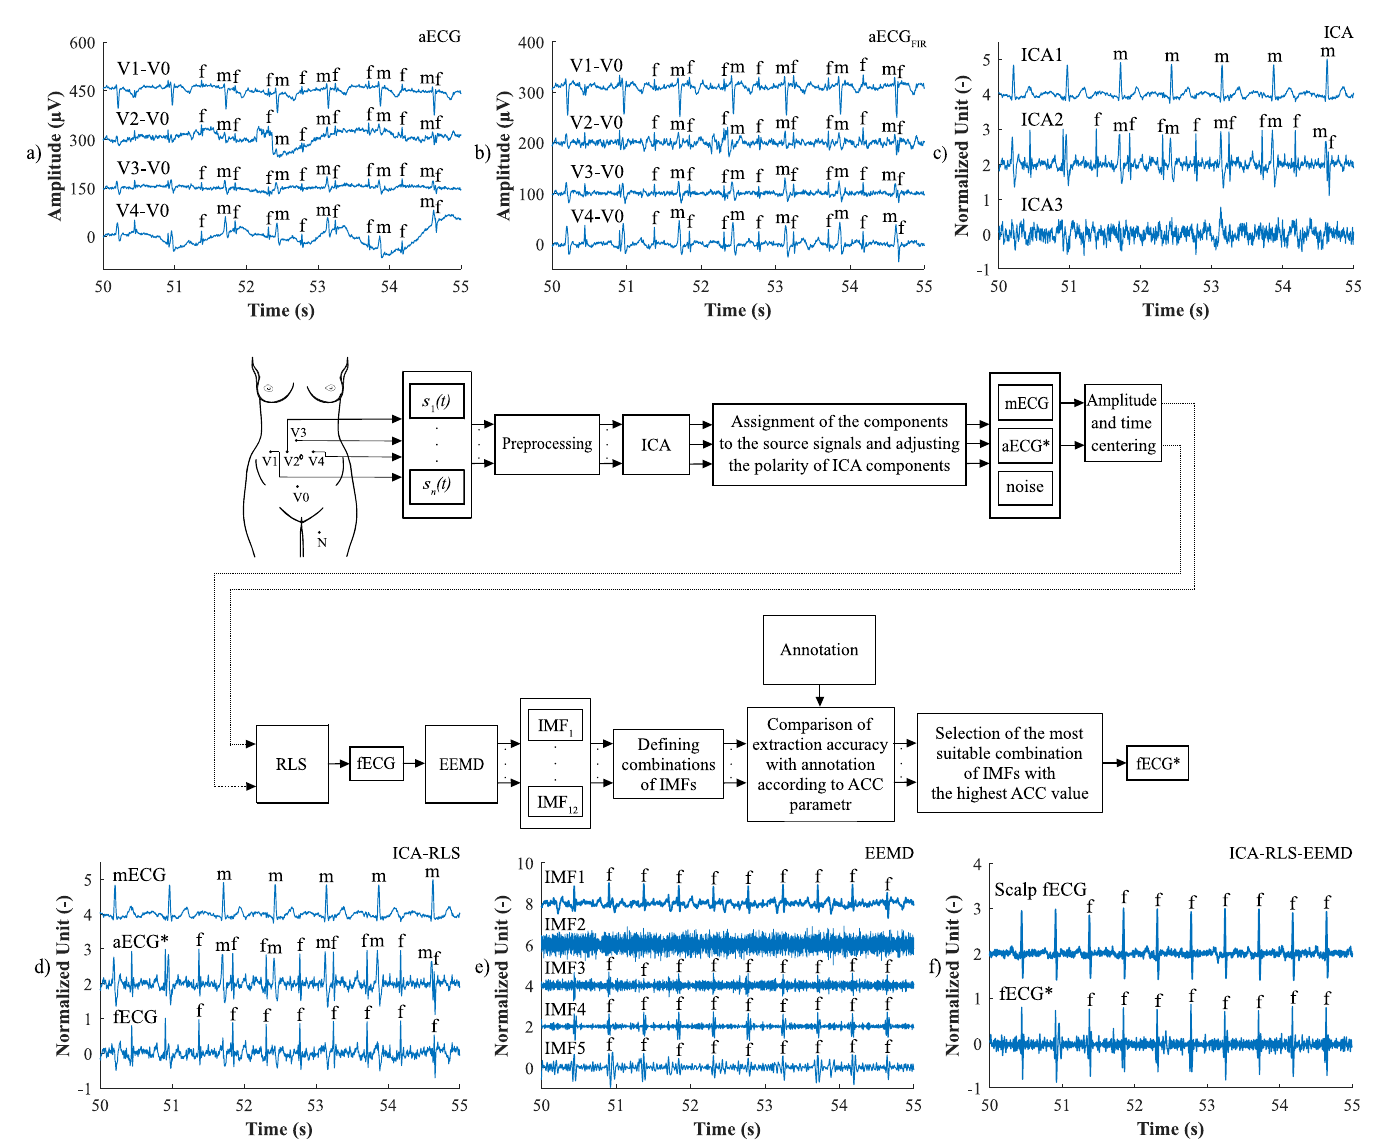
Fig 3. Block diagram explaining the ICA-RLS-EEMD method: a) input aECG signals; b) input aECG FIR signals preprocessed by the FIR filter; c) three source components extracted by the ICA method; d) ICA components assigned to the source signals, which were time and amplitude centred and served as inputs to the RLS algorithm; the fECG signal was the output of the ICA-RLS algorithm; e) the first five IMFs that were obtained after the application of the EEMD method; f) a reference scalp electrode recording and the resulting fECG � , which was extracted after applying the ICA-RLS-EEMD method.